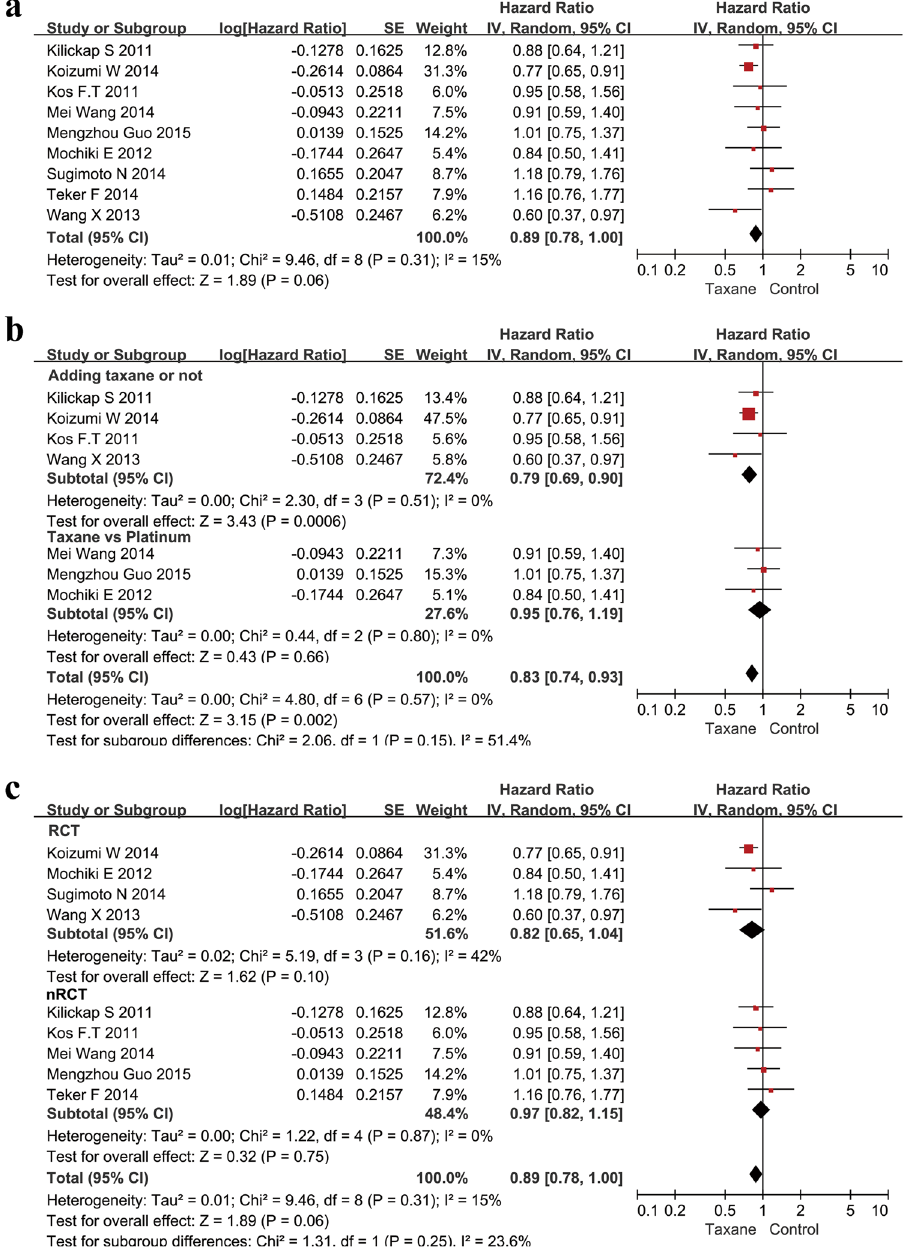
Figure 4. Meta-analysis of the progression-free survival (PFS). ( a ) Forest plots of the hazard ratio (HR) for the PFS comparing Taxane with control. ( b ) Subgroup analysis between the adding and replacing groups of the PFS. ( c ) Subgroup analysis between the RCT and nRCT groups of the